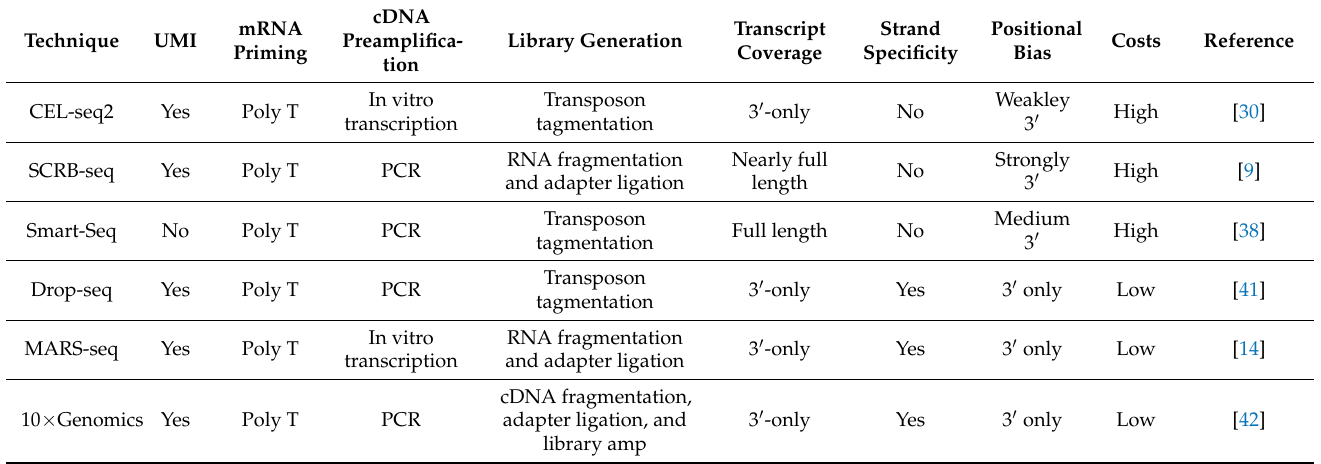
Table 1. Comparison of single-cell techniques in the form of the methodology used and advantages gained for analysis of mRNA